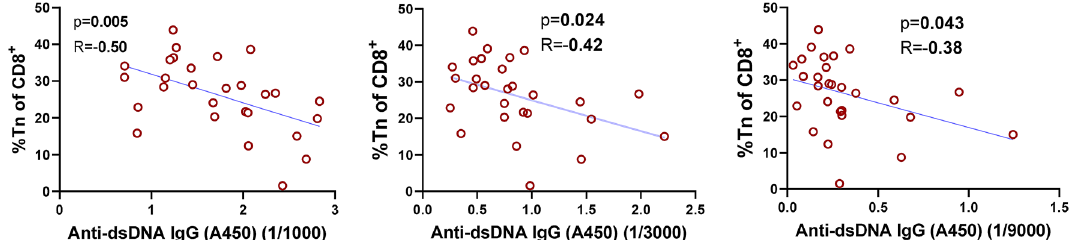
Figure 6. SOCS1-KIR mediated lymphocyte changes correlated to reduced anti-DNA IgG production. Linear correlation was evaluated for the relative frequency of CD8+ naïve T cells and anti-dsDNA IgG.